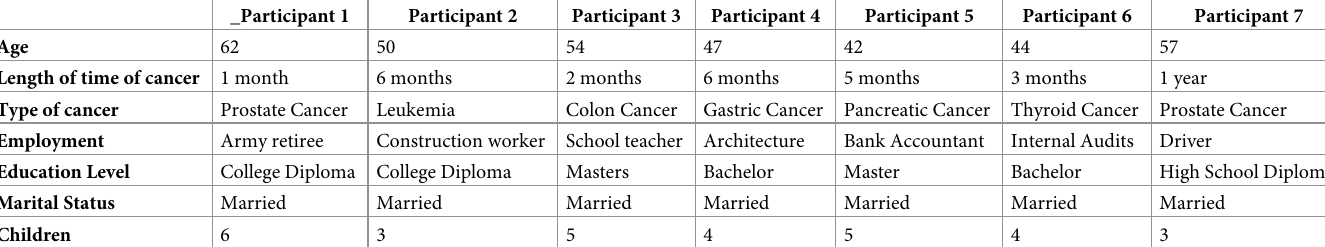
Table 1. Demographics data of the participants.